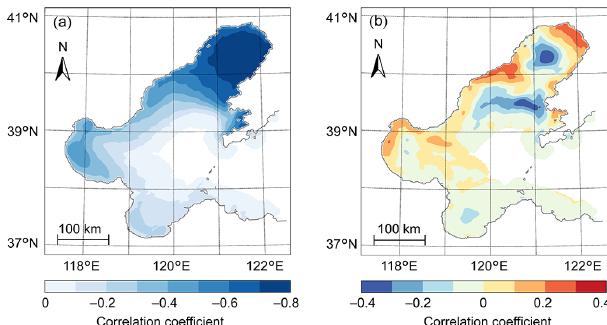
Figure 21. Spatial correlation between daily sea ice concentration in the Bohai Sea and (a) vertically integrated ocean heat content, and (b) vertically integrated ocean salt content from the surface to the bottom of the mixed layer during the ice period